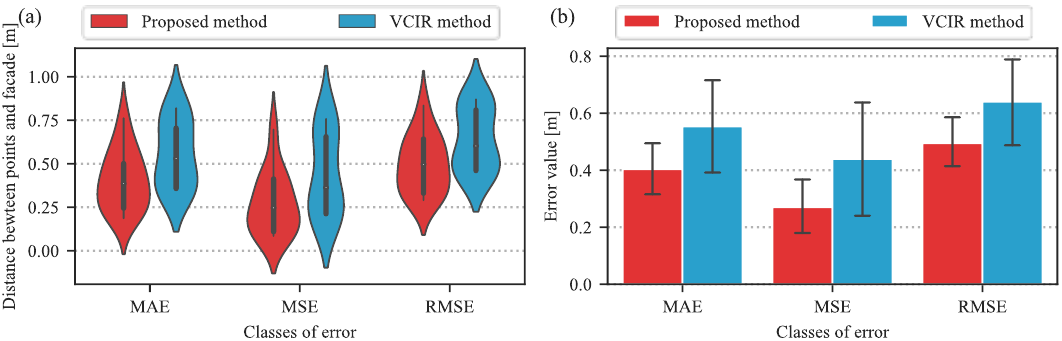
Figure 10. Violin plots and bar plot for the errors of facade extraction for the IQmulus & TerraMobilita Contest dataset: ( a ) violin plot of the distances between points and facade, where the shape of the violin displays the probability density distribution of the data; the black bar depicts the interquartile range, the 95% confidence interval is shown by the inner line branching from it, and the median is shown by a white dot; and ( b ) bar plot of the total facades error, where the vertical bars show the mean of the data and the error line shows the 95% confidence interval.